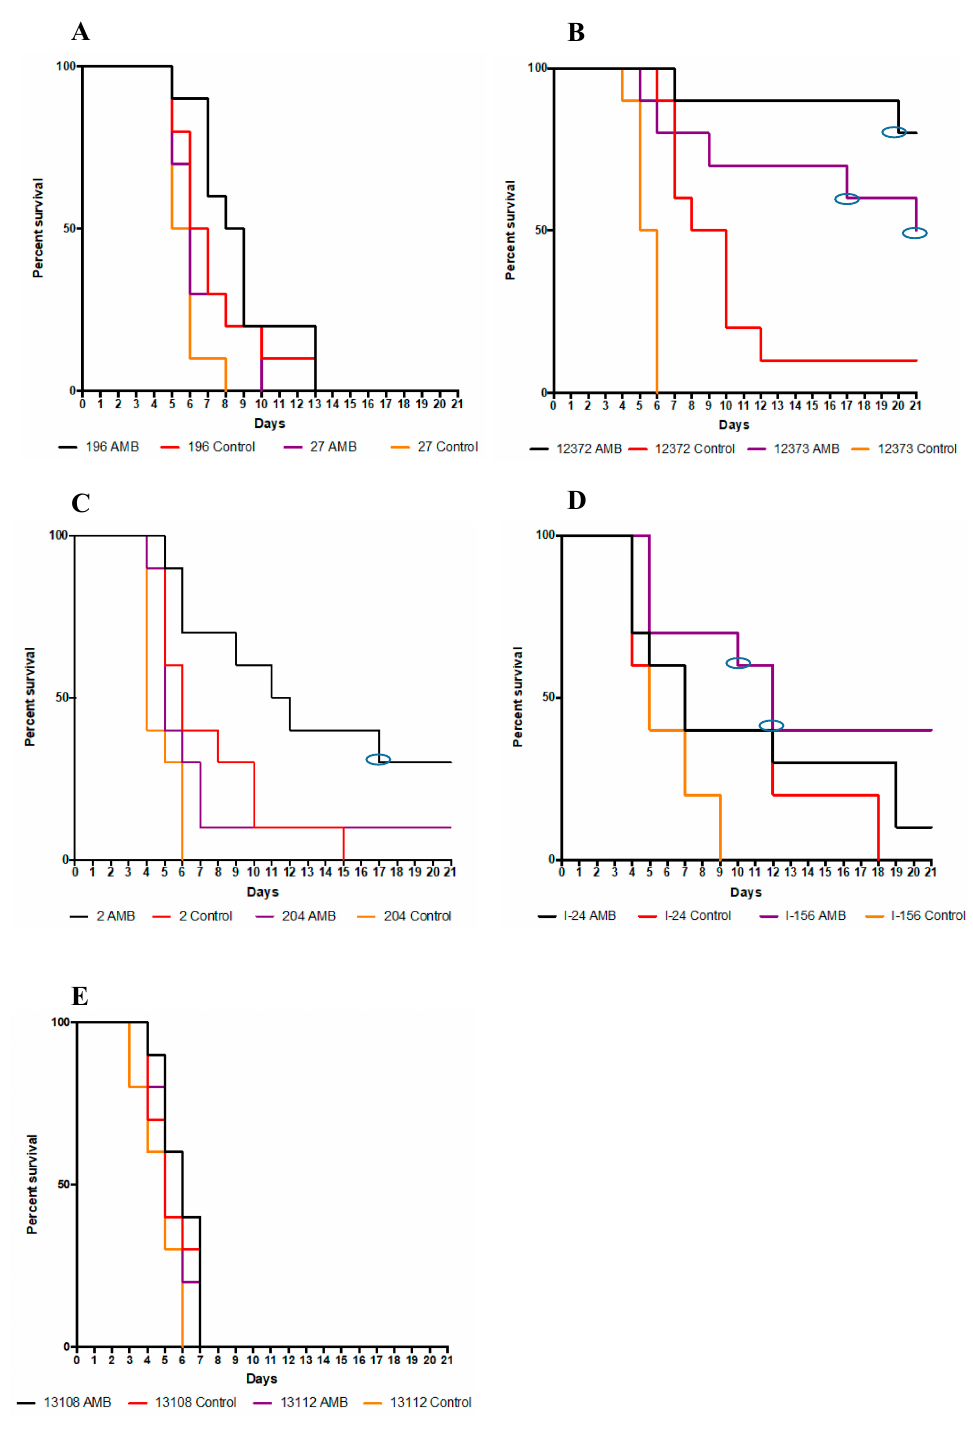
Figure 1. Survival of neutropenic AMB-treated and control BALB/c mice infected with the isolates from the four Candida auris clades: isolates 27 and 196 ( A ) (South Asian clade), isolates CBS 12,372 {12,372} and CBS 12,373 {12,373} ( B ) (East Asian clade), isolates 2 and 204 ( C ) (South African clade) and isolates I-24 and I-156 ( D ) (South American (clade). Two environmental isolates, CDC B-13,108 {13,108} and CDC B-13,112 {13,112} ( E ), from the South American clade were also tested. The infec- tious dose was 10 7 CFU/mouse. Daily 1 mg/kg of amphotericin B (AMB) treatment began 24 h postinfection. After 21 days the survival rate was analyzed by Kaplan–Meier test. Blue ellipses in survival curves in cases of mice infected with isolates 12,372 and 12,373 (East Asian clade) ( B ), iso- late 2 (South African clade) ( C ) and isolate I-156 (South American clade) ( E ) indicate that these mice showed ataxia 2–3 days before their death.